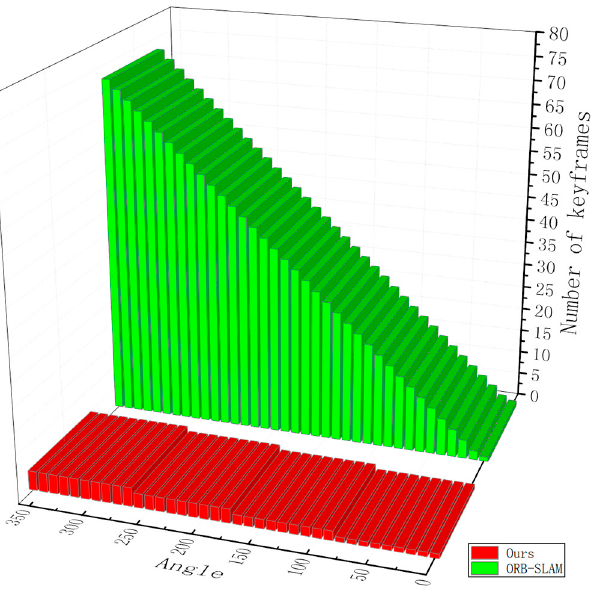
Figure 14. The number of keyframes achieved and maintained by the camera on a robot after rotating one circle in place. Our method needs just four images, while ORB-SLAM adds a new image for every 5° of rotation.